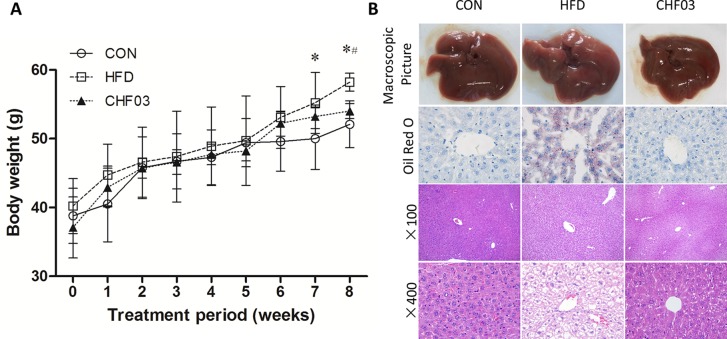
Changes in body weight and liver pathology. (A) Modulation of body weight by CHF03. A significant increase in body weight was observed at the 8th week after the successful establishment of the NAFLD model. After the 8 week CHF03 intervention, the CHF03 group exhibited a significant reduction in body weight compared with HFD group. (B) Representative macroscopic liver images, Oil Red O, and H&E-stained sections of liver tissues (original magnification ×100 and ×400). Lipid droplets are stained in orange. Macrovesicular and microvesicular steatosis is observed in the hepatic lobule of HFD group. Average body weights at the end of the treatment period were significantly different between the CHF03 and HFD groups (#
p < 0.05) and between the HFD and CON groups (*p < 0.05). Groups: CON, control; HFD, high-fat diet; CHF03, Chinese Herbal Formula.